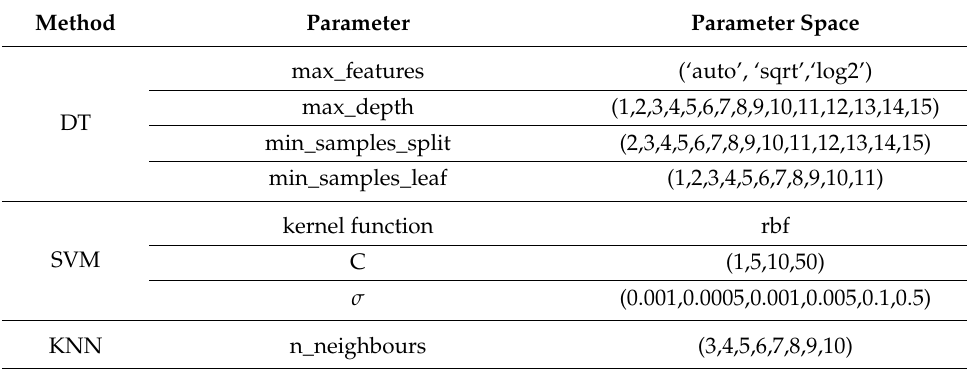
Table 4. Parameter settings for several machine learning methods.